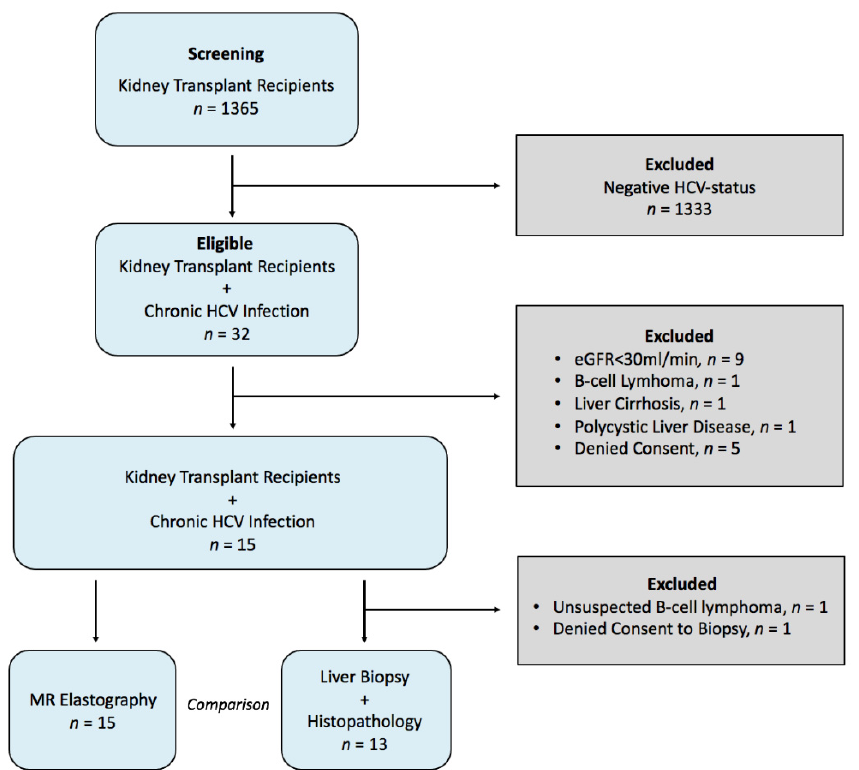
Figure 1. Study flow diagram. eGFR = estimated glomerular filtration rate.